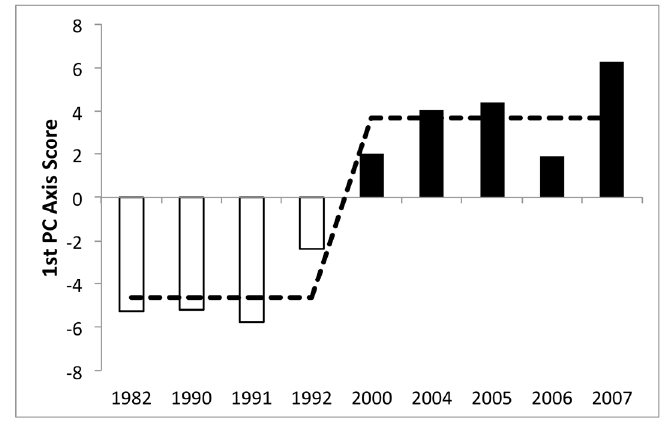
Figure 6. First principal component axis scores for the 7-taxon matrix of phytoplankton in the inner bay of Green Bay. Open bars are pre-invasion years, black bars are post-invasion years. Dashed line indicates mean scores and shift using Regime Shift Detection (RSD) procedures, with significance confirmed by permutation testing with ANOSIM ( p = 0.008).